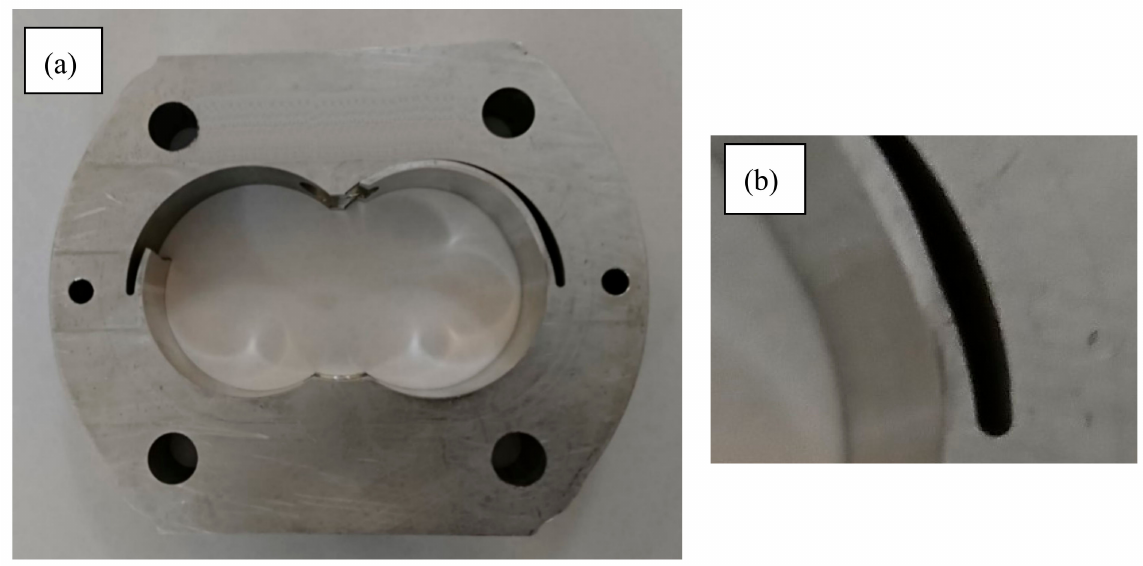
Figure 5. Central body of the first version of circumferential compensation [2]: ( a ) after durability tests; and ( b ) view of the cross-section of the reduced compensation